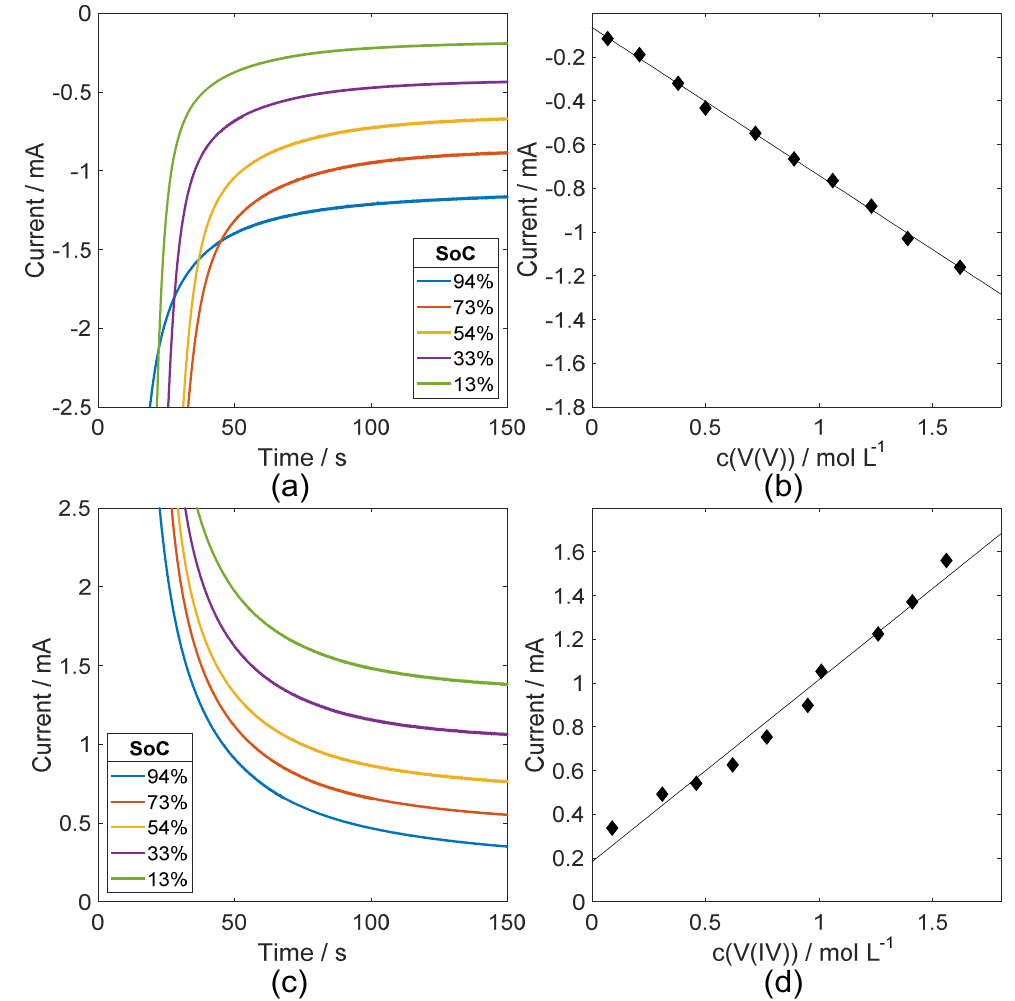
Figure 6. Results of chronoamperometric (CA) measurements with sensor in positive electrolyte with different SoCs; reduction current curves ( a ); current values versus SoC ( b ); oxidation current curves ( c ), current values versus SoC ( d ) (±0.7 V vs. open circuit voltage (OCV), platinum pseudo reference, active area 1 cm²).